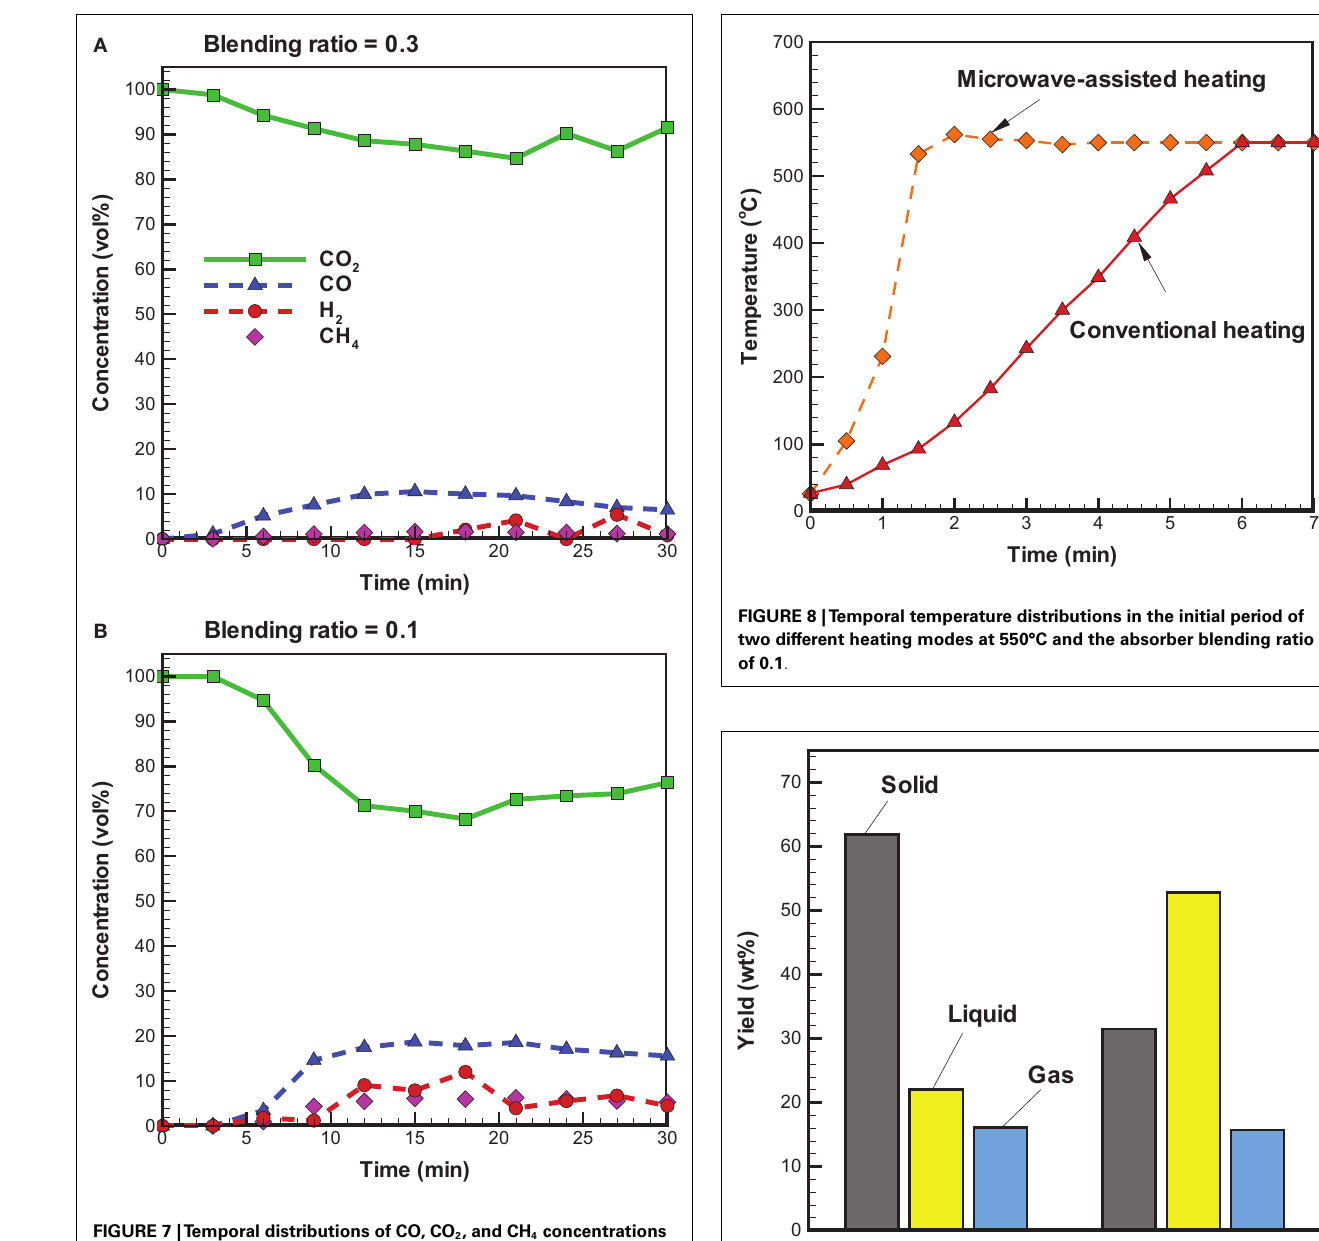
FIGURE 7 |Temporal distributions of CO, CO 2 , and CH 4 concentrations from bagasse pyrolysis under microwave-assisted heating at 550°C and the blending ratios of (A) 0.3 and (B) 0.1 .